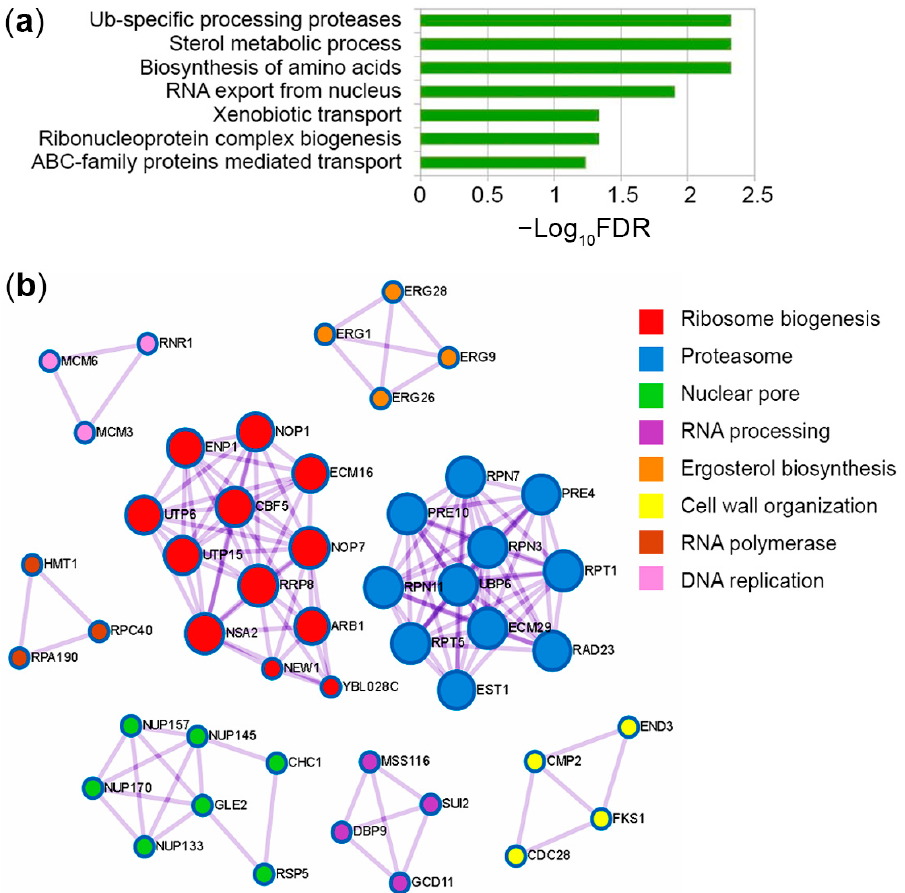
Figure 1. Top enriched terms ( a ) and the molecular complexes ( b ) detected across proteins upregu- lated in YPL relative to WT strain under normal conditions. The names of the proteins used for the analysis are listed in Table S2. Additional quantitative proteomic data are given in Table S3.